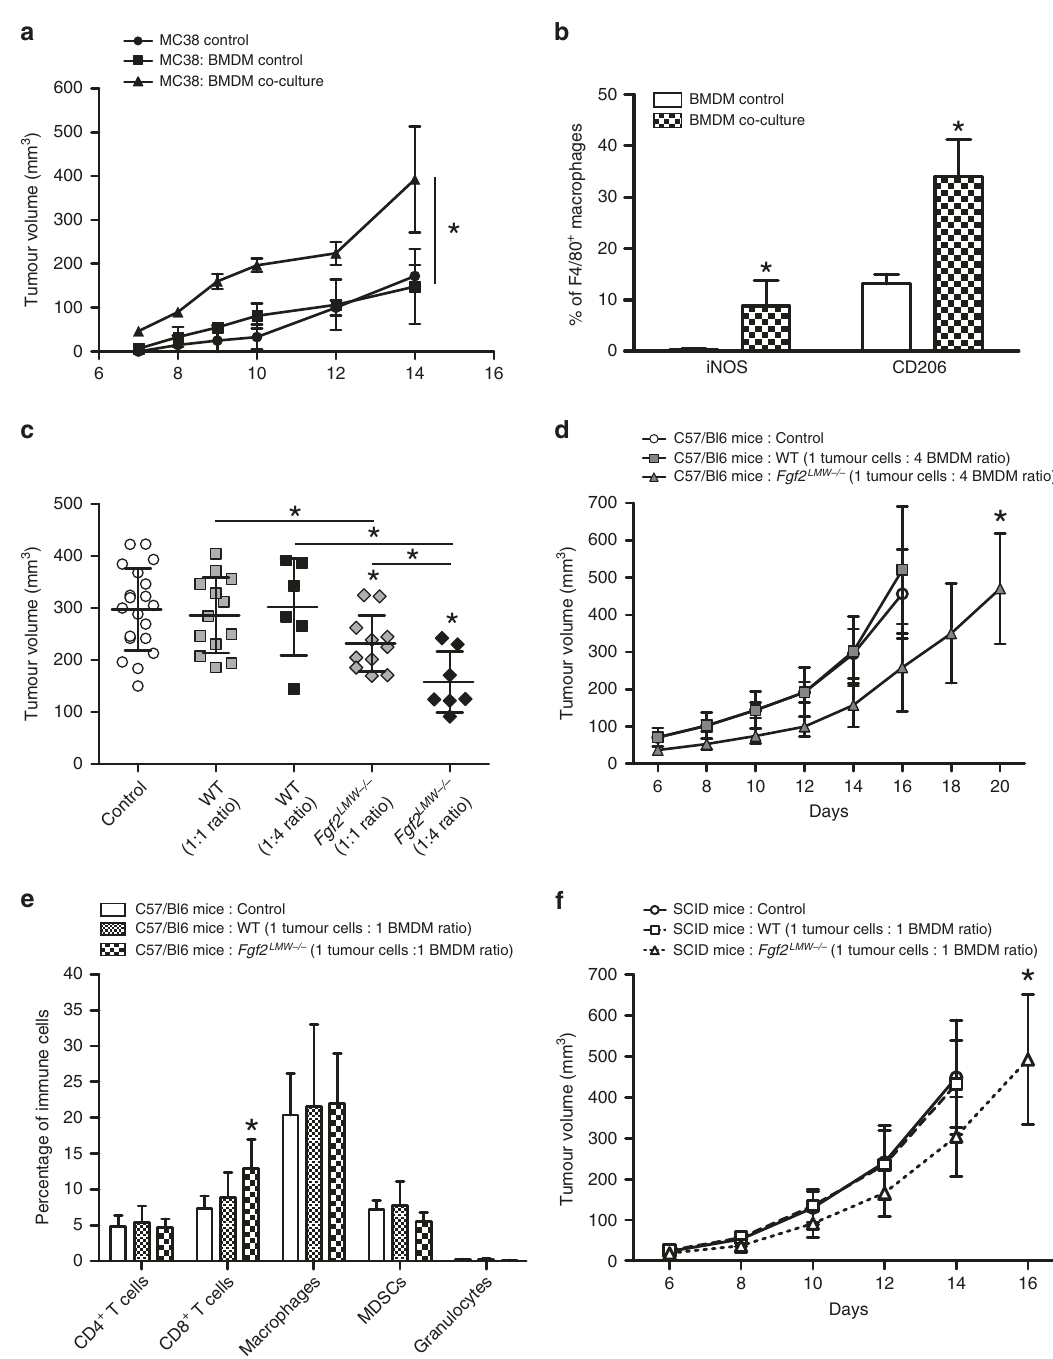
Fig. 5 Co-injection of Fgf2 LMW − / − BMDM with tumour cells delays tumour growth. a Growth curves following subcutaneous co-injection of MC38 tumours cells and WT BMDM pre-educated with MC38 tumour cells. b iNOS and CD206 expression in BMDM following pre-education with MC38 tumour cells. c Tumour volume 14 days post co-injection of MC38 tumour cell with WT or Fgf2 LMW − / − BMDM at different concentrations. d Growth curves following subcutaneous co-injection of MC38 with either WT or Fgf2 LMW − / − BMDM at a ratio of 1 tumour cells: 4 BMDM in C57Bl6 WT mice. e Flow cytometry analysis of immune cells isolated from WT BMDM and Fgf2 LMW − / − BMDM subcutaneous tumours of C57Bl6 mice 14 days post-tumour cell injection. f Growth curve analysis following subcutaneous co-injection of MC38 with either WT BMDM or Fgf2 LMW − / − BMDM at a ratio of 1 tumour cells: 1 BMDM in SCID mice. * represents statistical signi fi cance compared with control mice ( p ≤ 0.05). Error bars indicate S.D. N = 10 in each